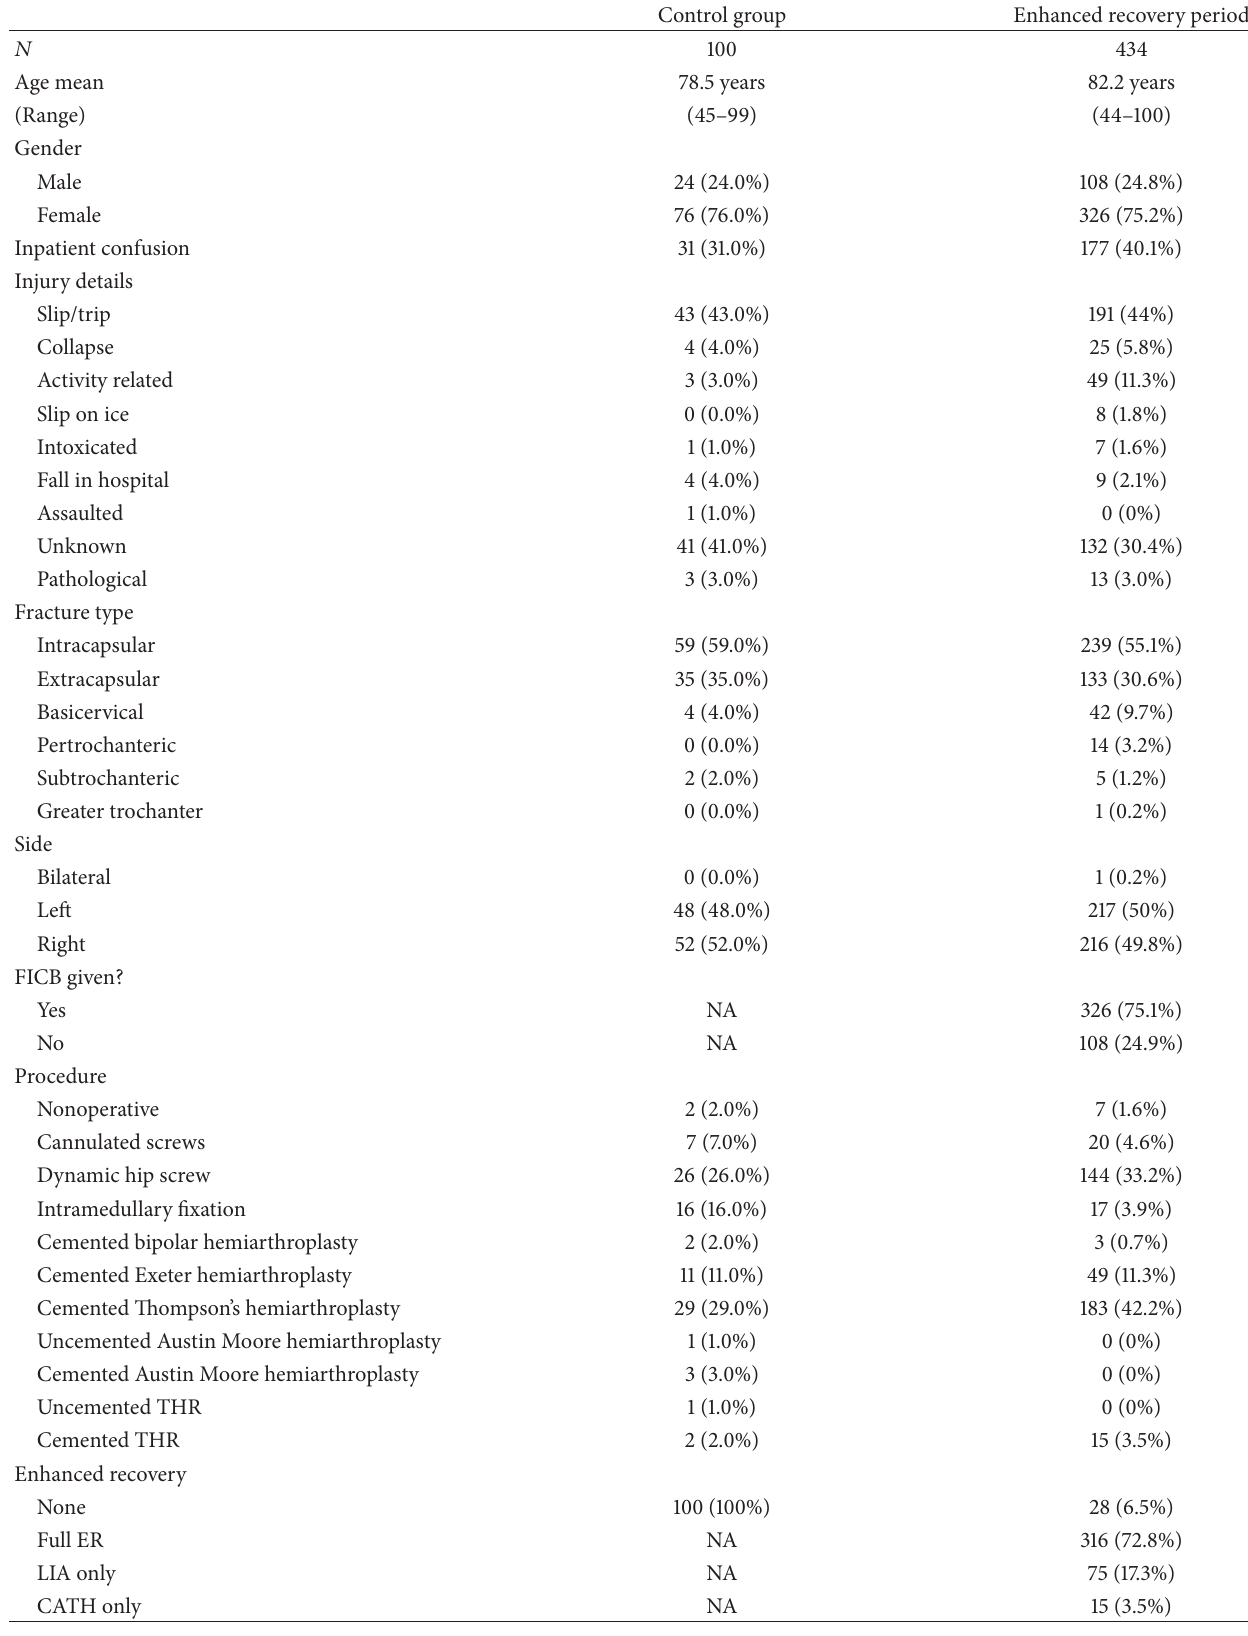
Table 1: Patient demographics, mechanism of injury, fracture pattern, and